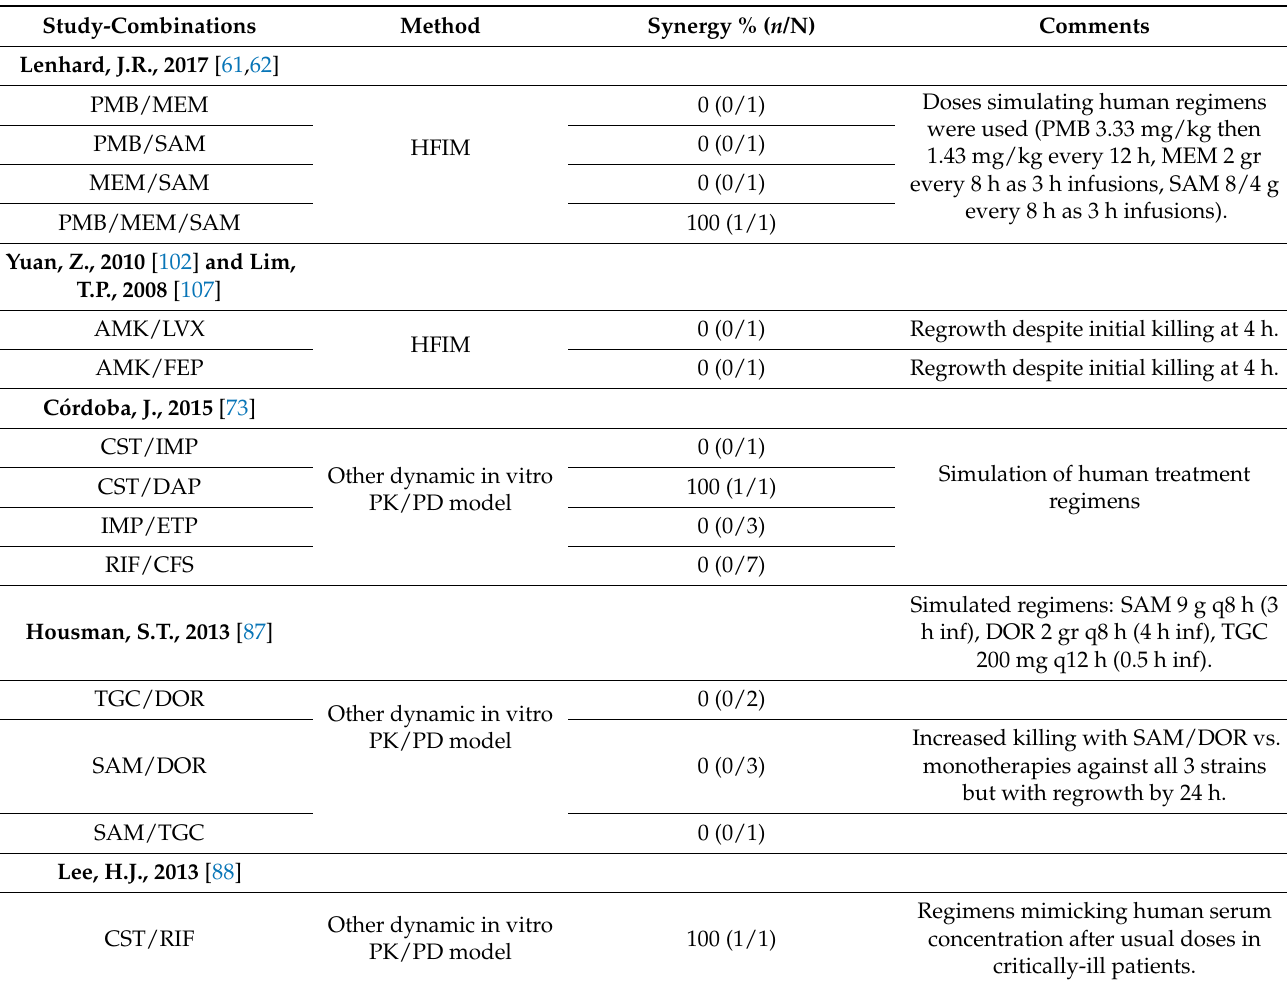
Table A4. Studies using dynamic in vitro PK/PD